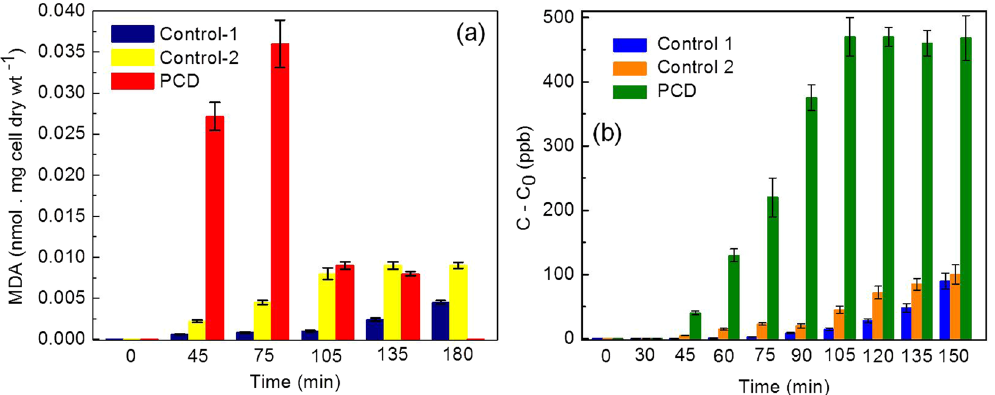
Figure 5. ( a) Lipid peroxidation kinetics of MDR E. coli induced by Fe/ZnO NPs and ( b ) leakage of K + ion from MDR E. coli cells subjected to PCD in presence of Fe/ZnO NPs. Initial MDR E. coli concentration = 1.2 × 10 7 CFU/mL, Temperature = 35 ± 2 °C, pH = 6.5, [Fe/ZnO NPs] = 500 mg/L. Error bars indicate the standard deviation of replicates (n =